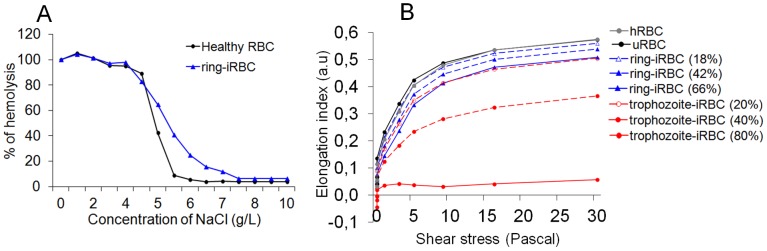
Osmotic fragility and deformability of uninfected or P. falciparum infected red blood cells.Osmotic fragility of a population of ring-iRBCs with 49% parasitemia was slightly decreased (A). Ektacytometer analysis showed that trophozoite-iRBCs were totally rigid, while ring-iRBCs were moderately, but significantly less deformable than control RBCs (uRBCs or hRBCs) (B).